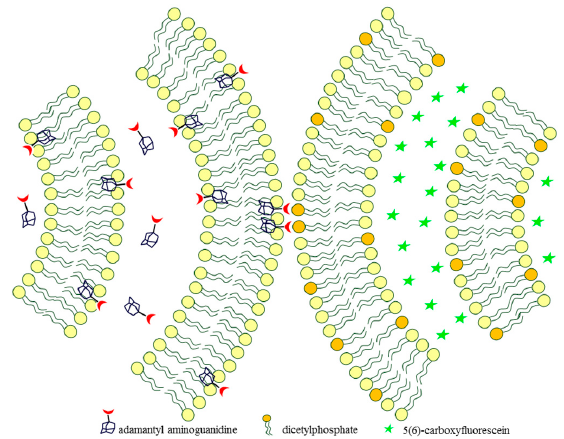
Figure 5. Liposomes containing adamantyl aminoguanidines interacting with complementary